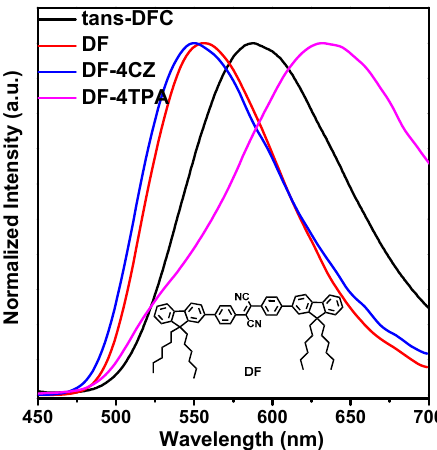
Figure 5. The PL spectra in films of trans -DFC, 2,3-bis(4-(9,9-dihexyl-9 H -fluoren-2-yl)phenyl) fumaronitrile (DF), and DF dispersed in carbazole with a mole ratio of 1:4. Inset: the structure of DF. (CZ = carbazole; TPA = triphenylamine).